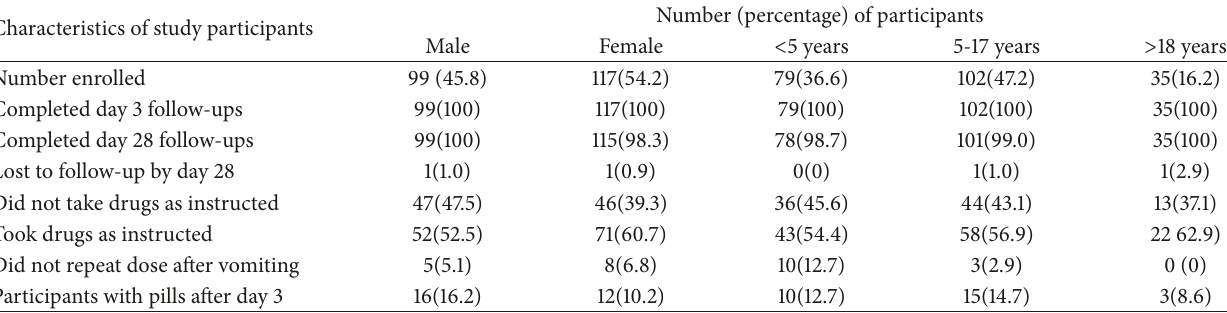
Table 1: Characteristics of study participants and treatment dose outcomes.